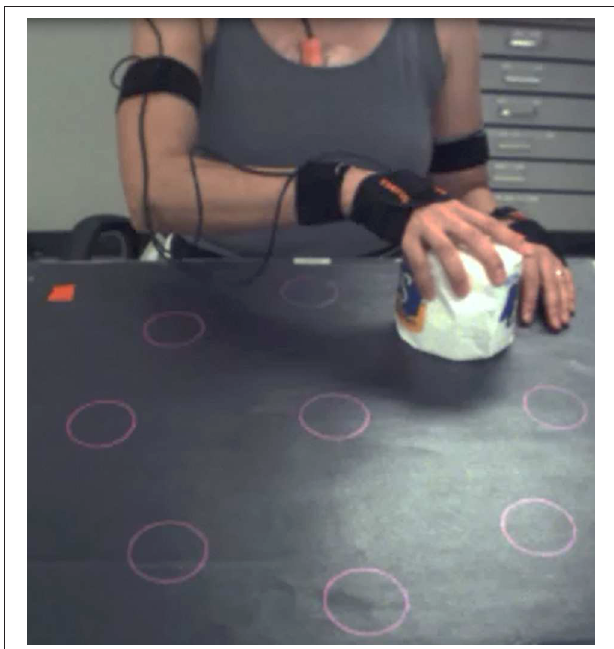
FIGURE 1 | Tabletop activity set-up. Healthy individual wearing the sensors and transporting the object from center to a